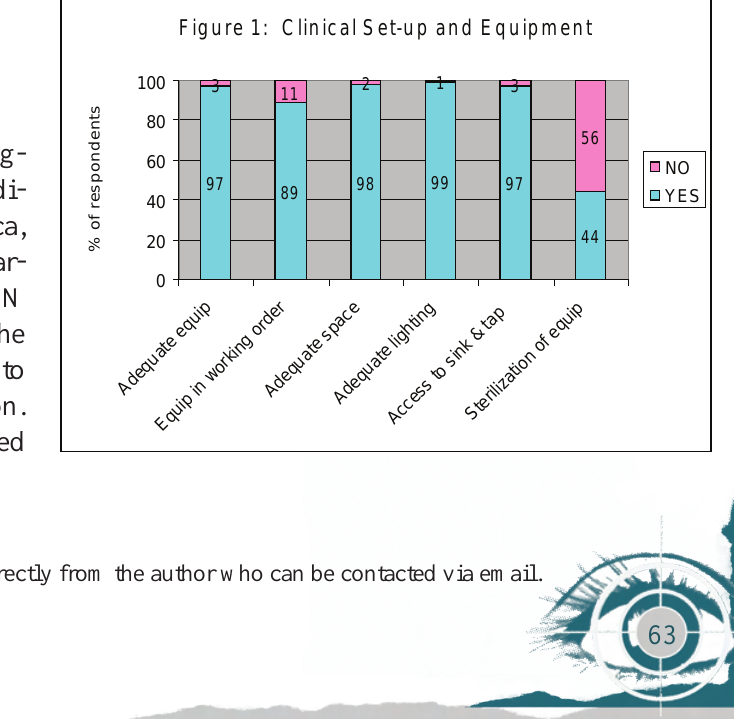
Figure 1: Clinical Set-up and